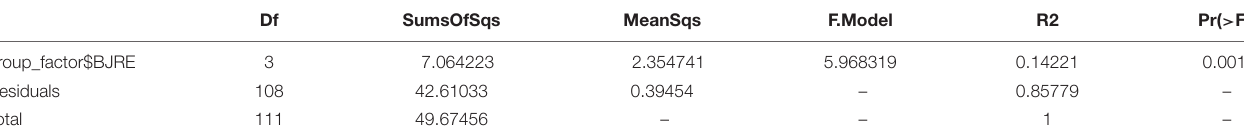
TABLE 3 | Adonis analysis of the difference among samples fungi in associated with Gossypium